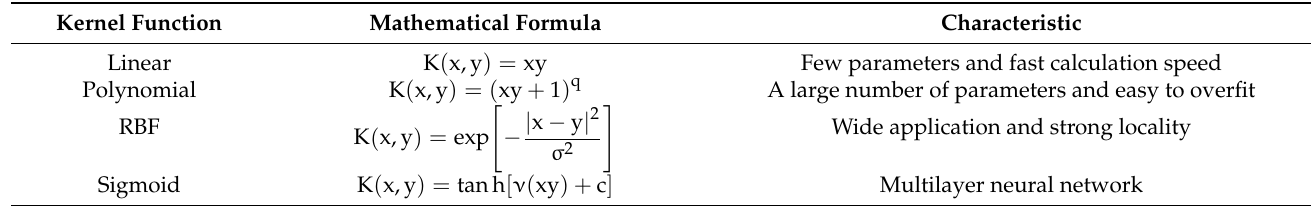
Table 1. The expressions and characteristics of four kernel functions.